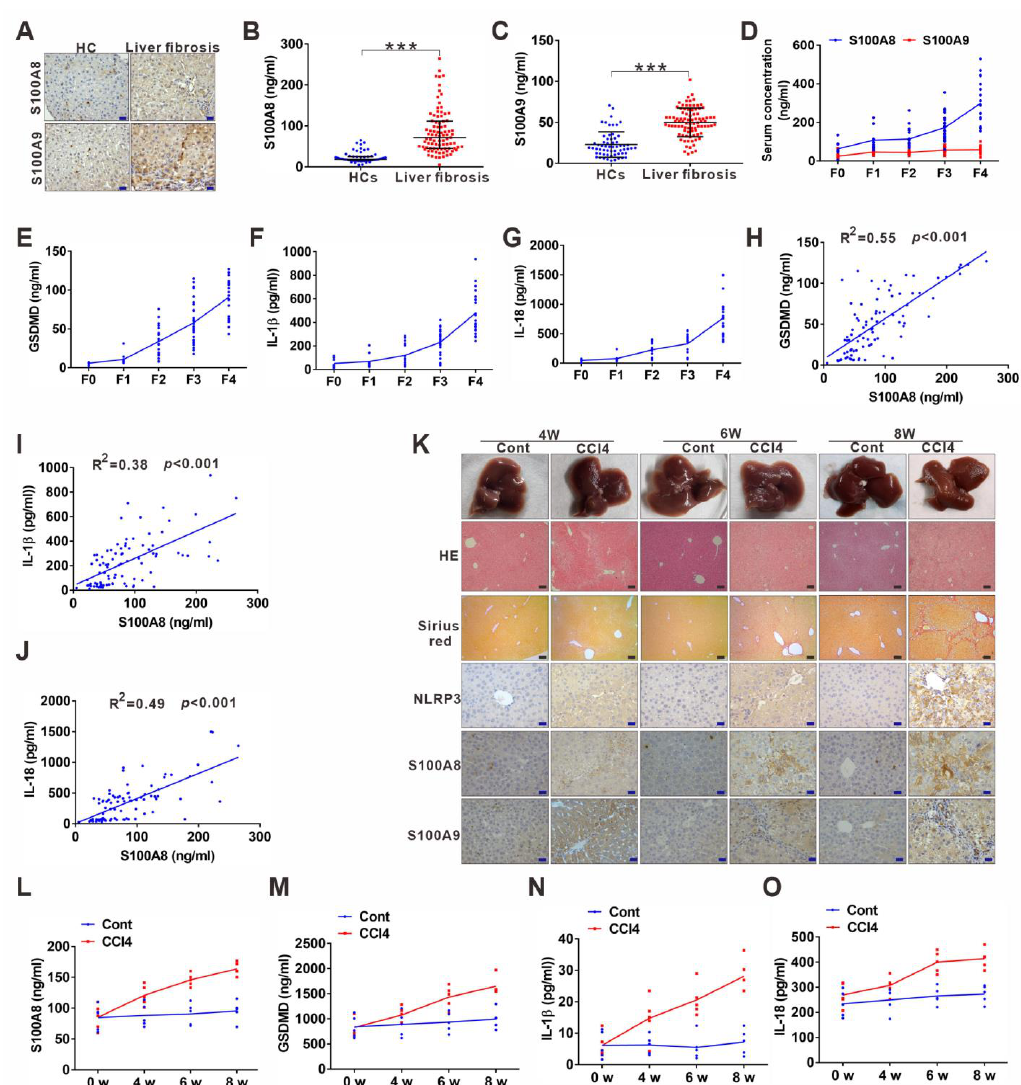
Figure 3. DAMP S100A8 along with NLRP3 inflammasome-dependent pyroptosis is positively related to the progression of liver fibrosis. ( A ) Representative IHC images for S100A8 and S100A9 in liver sections from liver fibrosis patients and HCs. ( B , C ) ELISA analyses for serum levels of S100A8 and S100A9 in liver fibrosis patients and HCs. ( D ) Comparison of serum S100A8 and S100A9 levels in liver fibrosis patients with different phases. ( E – G ) Distribution of serum GSDMD (E) , IL- 1β ( F ), and IL-18 (G) levels in liver fibrosis patients with different phases (F0 – 4). ( H – J ) Correlation between serum S100A8 levels and GSDMD ( H ), IL- 1β ( I ) or IL-18 ( J ) levels in liver fibrosis patients. (K) Representative mouse liver morphology and staining with H&E and Sirius Red. ( L – O ) IHC staining of mouse liver sections for NLRP3, S100A8, and S100A9. Black scale bar: 100 µm; Red scale bar: 50 µm. ELISA analyses for serum levels of S100A8 (L) , GSDMD (M) , IL- 1β ( n ), and IL-18 ( O ) in 4-, 6-, and 8 week-mouse models of liver fibrosis. *** p < 0.001.